Question: Describe this figure in one sentence.
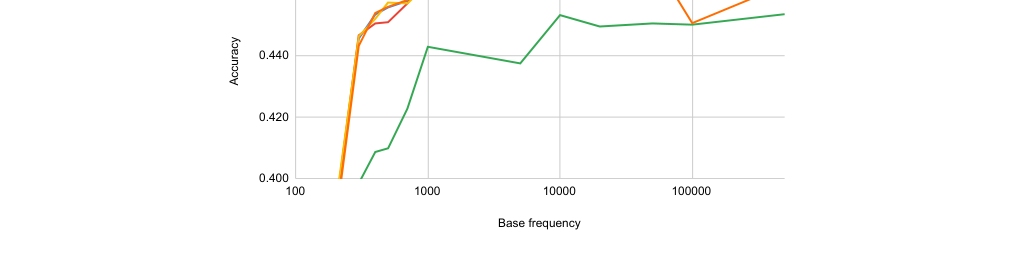
Answer: PG-19 accuracy for various ablation studies such as RPO (Random Position Offset), RSP (Random State Passing) and Prefix FAM tuning over different base frequency.